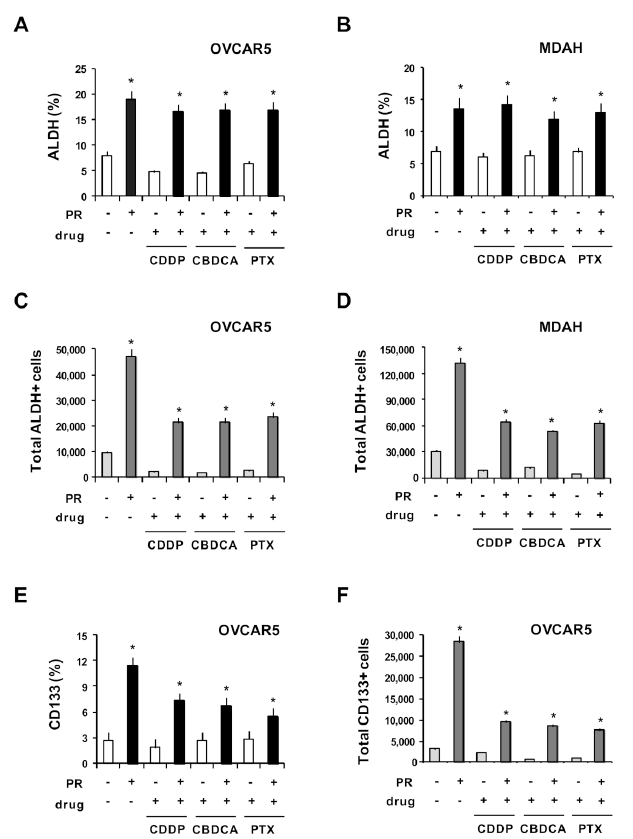
Figure 6. PR increased ALDH- and CD133-positive cells after drug treatment. OVCAR5 and MDAH cells were cultured for 5 days with PR (10%) in non-adherent conditions to form spheroids. Then cells were treated with CDDP, CBDCA and PTX for an additional 3 days. Treated cells were dissociated into single-cell suspensions by means of trypsinization. Histograms show the percentage of ALDH positive cells in OVCAR5 ( A ) and MDAH ( B ). Number of OVCAR5 ( C ) and MDAH ( D ) ALDH- positive cells. Histograms showing the percentage ( E ) and the number ( F ) of OVCAR5 CD133-positive cells. Data are expressed as mean ± SD of three replicates with three different PR pools and represent the percentage with respect to the control medium. * p < 0.01 (untreated vs. PR treated